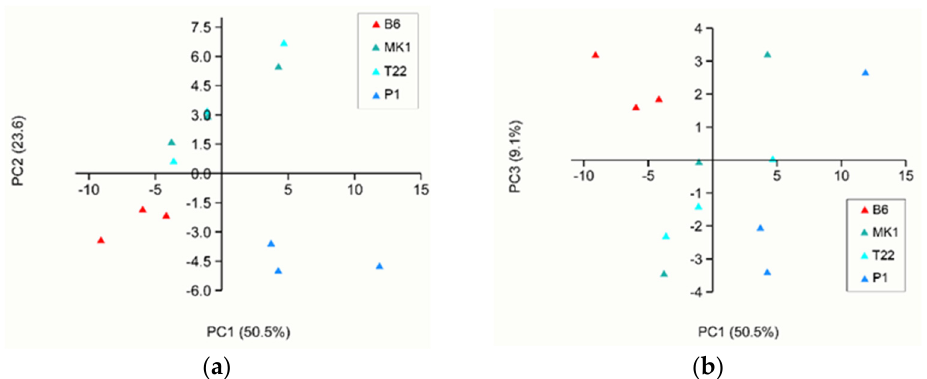
Figure 4. First three components of the PCA analysis of the PTR-Qi-TOF-MS data of VOCs emitted by samples grown in soil: ( a ) PC1 and PC2 plot; ( b ) PC1 and PC3 plot. The variance explained by each component is reported in brackets.